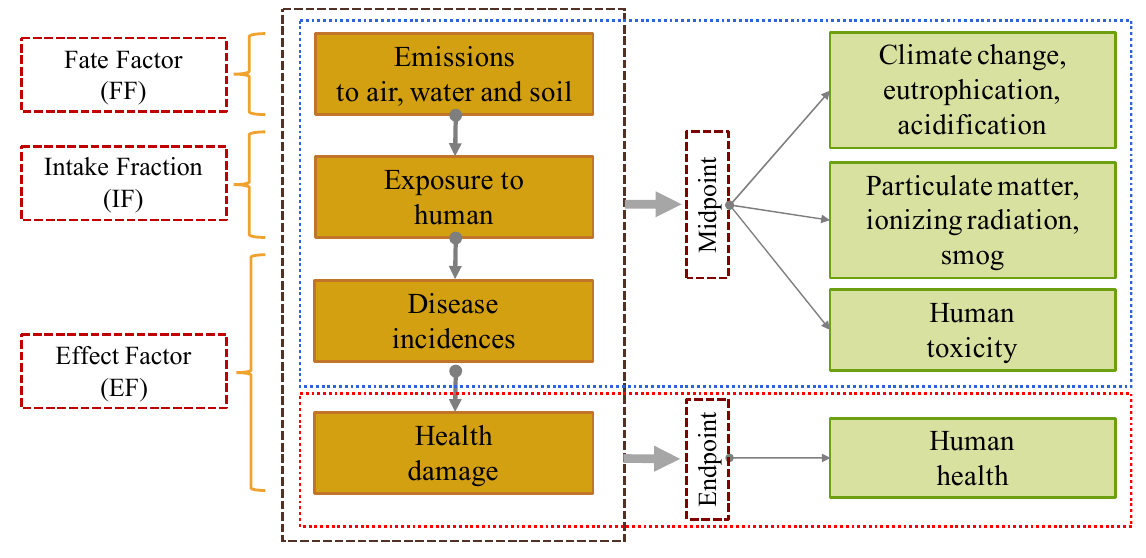
Figure 6. Toxicity flow of NMs.